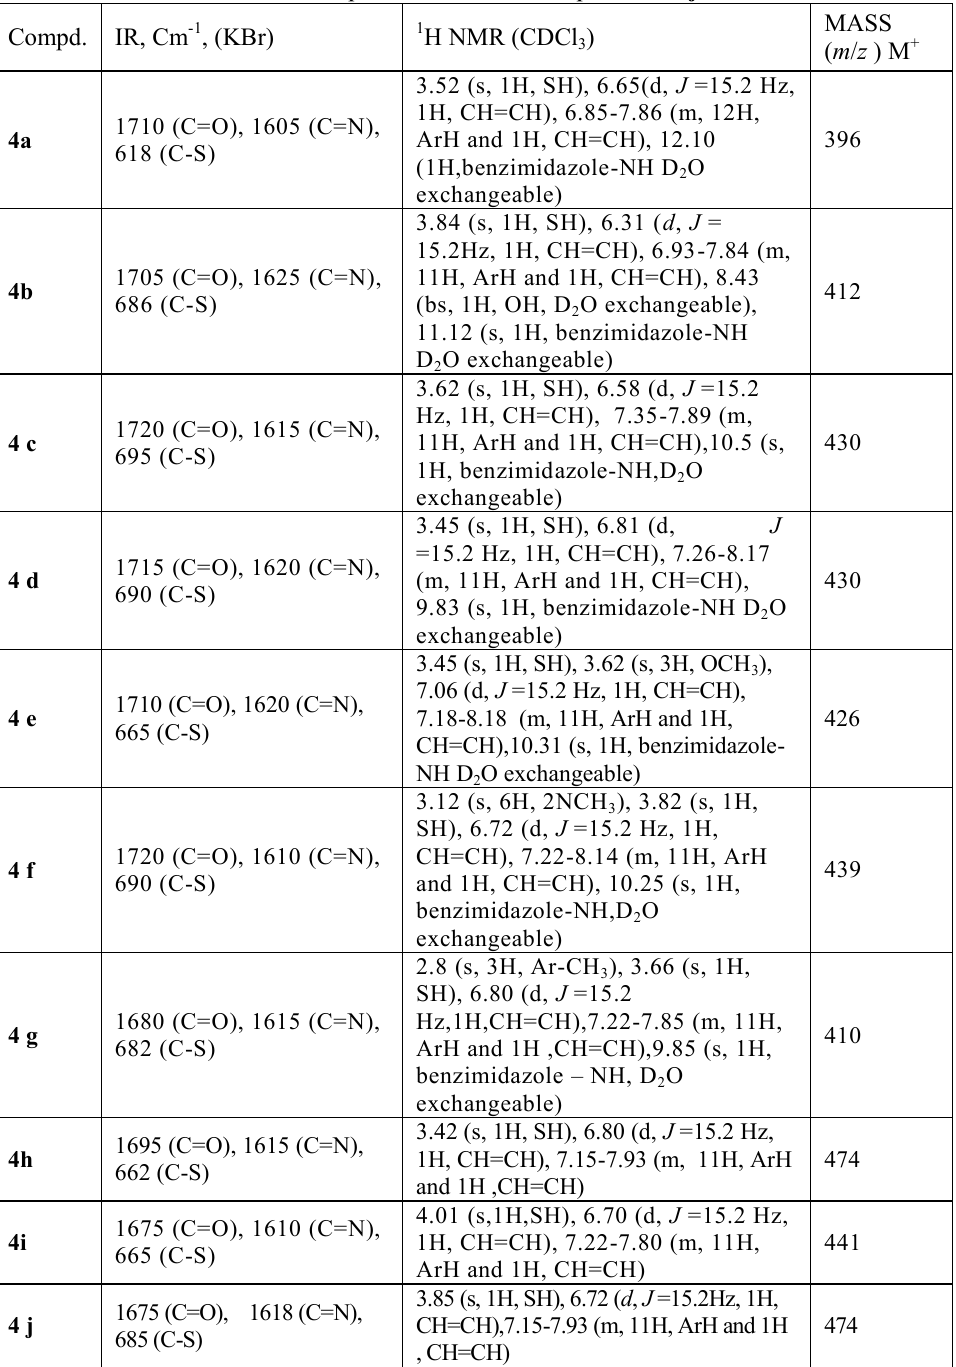
Table 2. Spectral data of the compounds